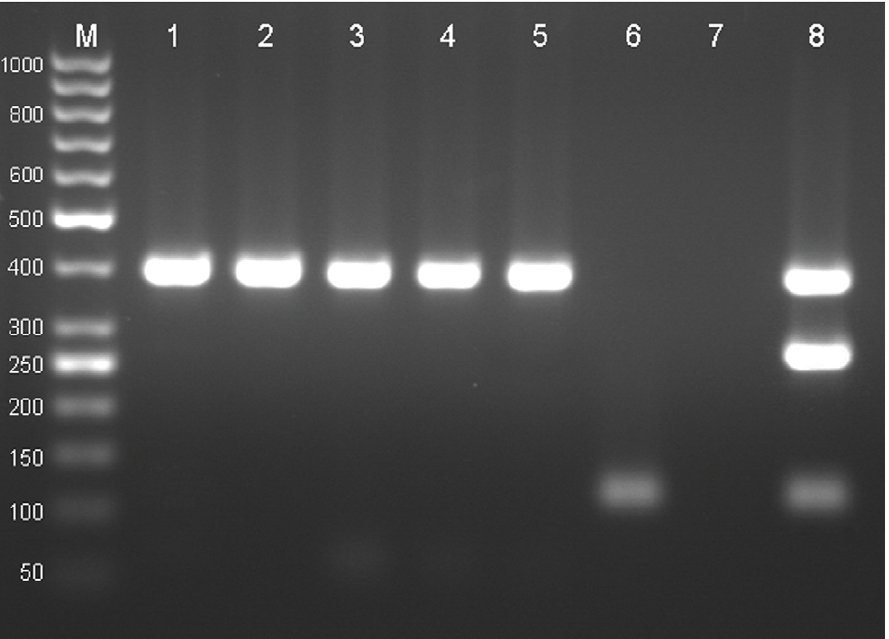
Figure 3. Multiplex PCR amplification of DNA extracted from adult worms in Razavi Khorasan Province. Lane M, 50 bp DNA ladder (Fermentas; Cat No SM0373); Lane 1–5, Echinococcus multilocularis taken from five jackals; Lane 6 E. granulosus isolated from a wolf; Lane 7, negative control; Lane 8, positive control, a mixture of standard DNA of E. multilocularis , E. granulosus , and Taenia. hydatigena .